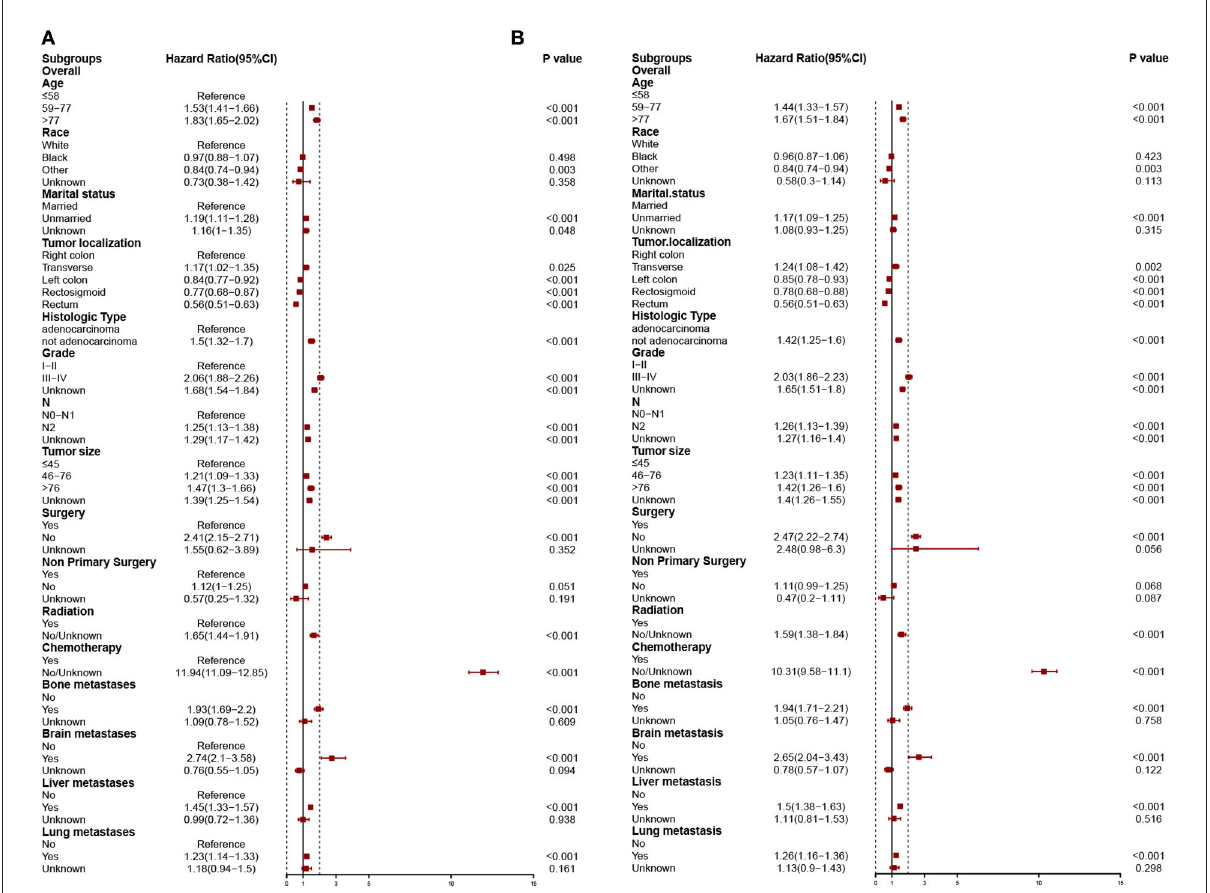
FIGURE3 Independent predictors of stepwise logistic regression models predict overall early death (A) and cancer-specific early death (B)